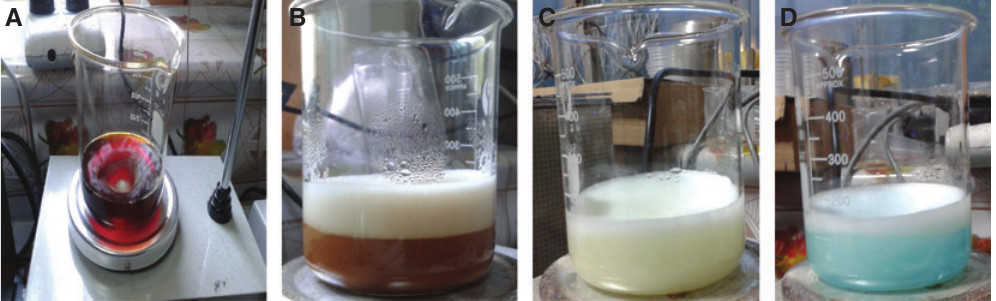
Figure 2: Preparation of copper sol: (A) before nanoparticle formation, (B) after adding L-ascorbic acid, (C) indication in reduction after adding NaBH , (D) after nanoparticle 4